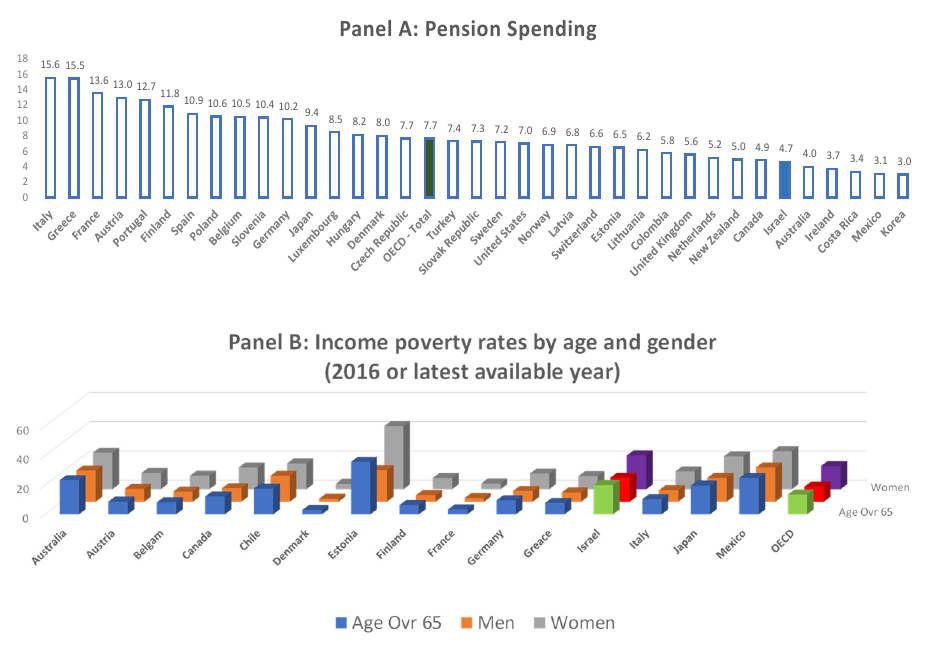
Figure 1. Poverty and Pension Spending in international Comparison. Authors’ elaboration based on the OECD data, 2020.